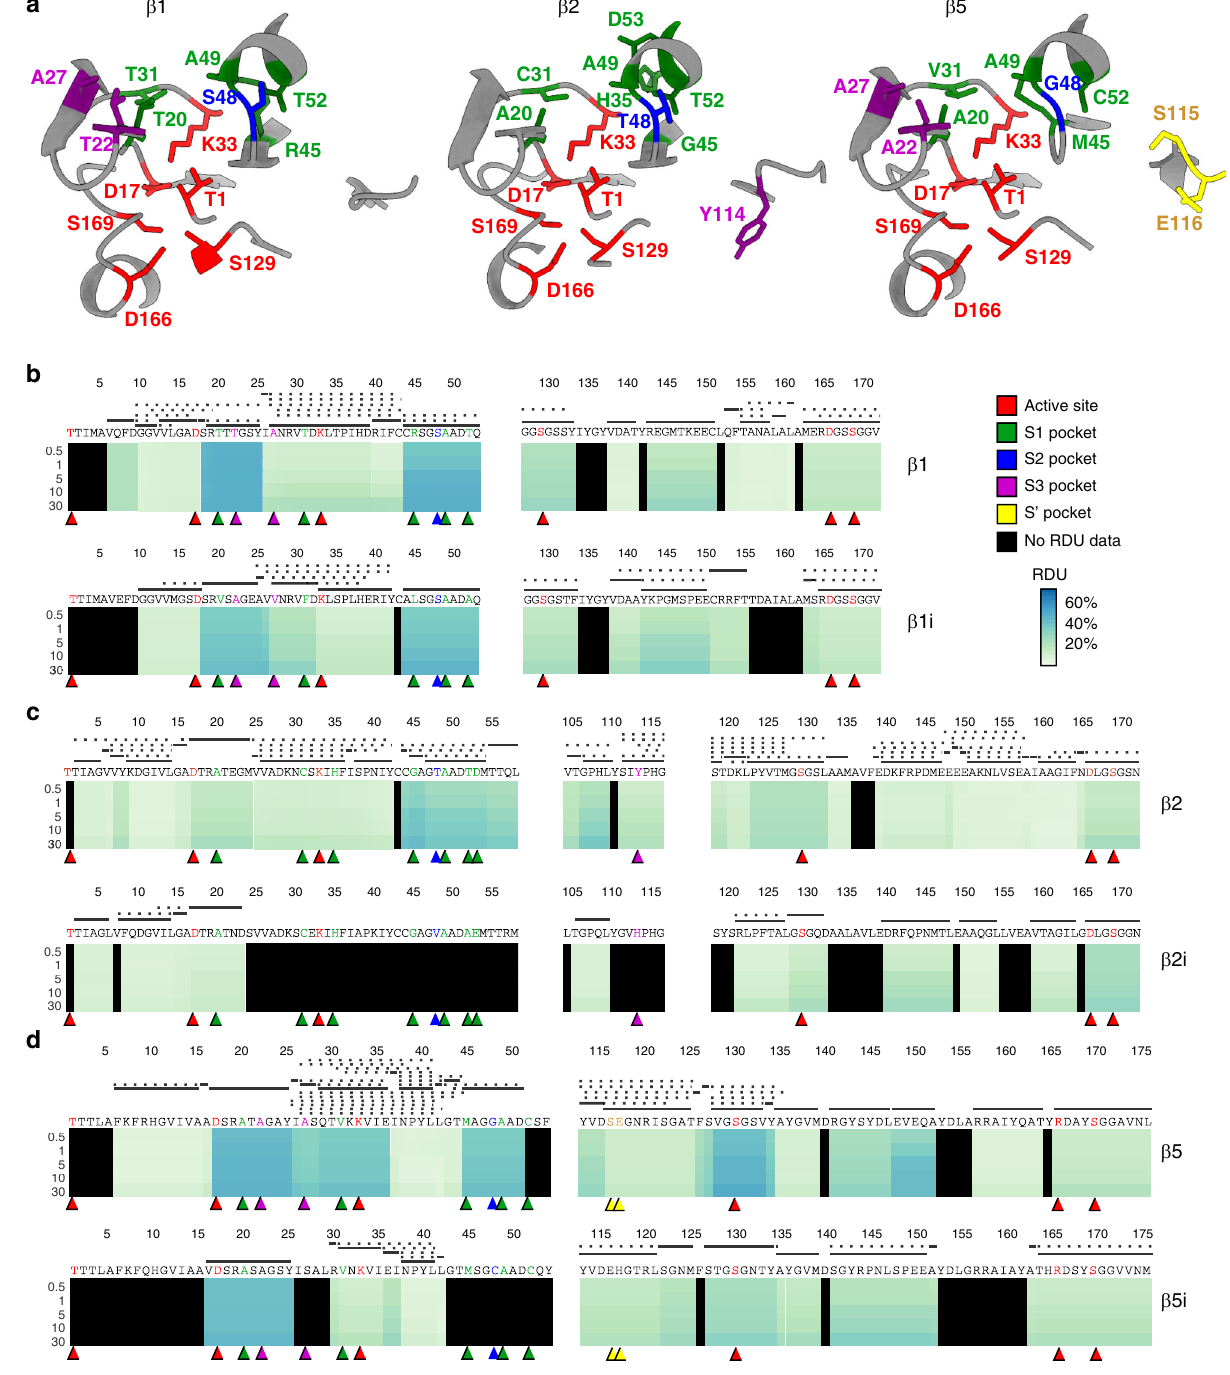
Fig. 3 Comparison of the catalytic-subunit solvent accessibilities. a Representation of the three catalytic subunits β 1 (left), β 2 (middle), and β 5 (right) of the std20S (PDB: 5LE5 35 ). The residues forming the active site and the substrate-speci fi c pockets are indicated and color-coded (active site, S1, S2, S3, and S ’ are represented in red, green, blue, purple, and yellow, respectively). b – d Deuteration heatmaps showing the relative deuterium uptake (RDU) for each timepoint of the kinetics, along the protein sequences of β 1/ β 1i ( b ), β 2/ β 2i ( c ), and β 5/ β 5i ( d ). The peptide sequence coverage is presented above the heatmaps as explained in Fig. 1d. For the sake of clarity, only the sequence stretches containing residues of the active sites and substrate pockets are represented